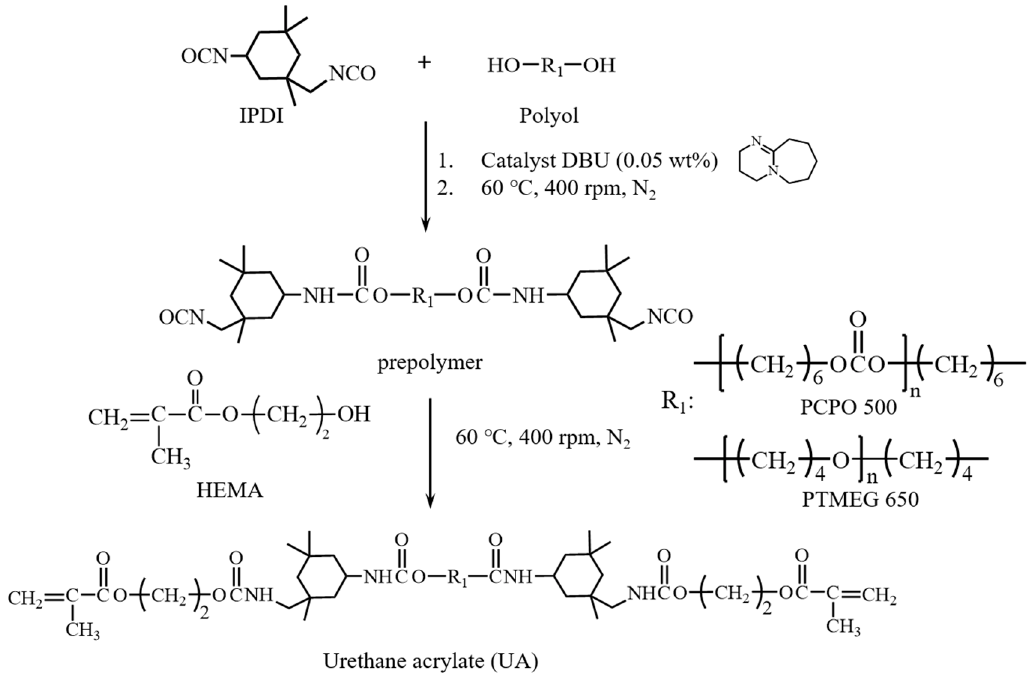
Figure 2. The preparation of urethane acrylate (UA).